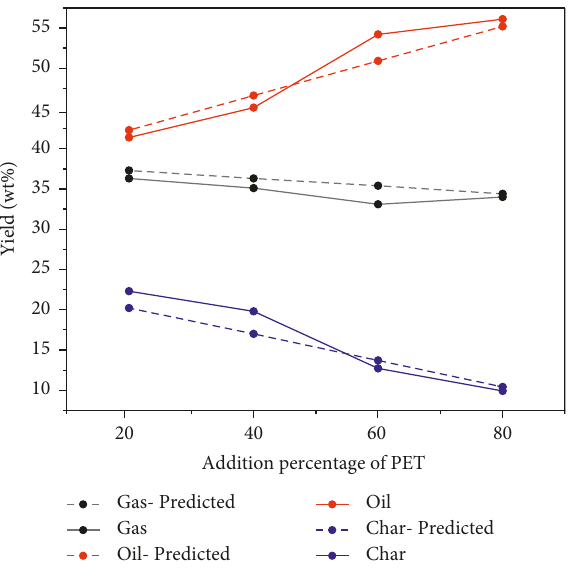
Figure 5: Effect of PET on biomass pyrolysis.